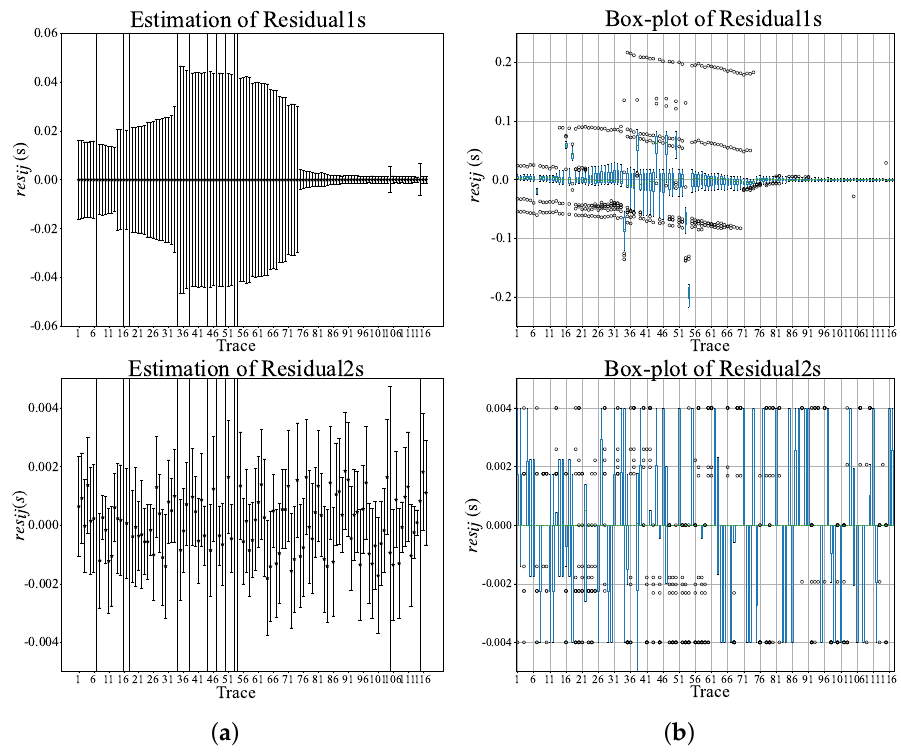
Figure 8. Assessment of results obtained by MCCC and improved MCCC: ( a ) mean and variance, and ( b ) median and interquartile range based on residual1s ( Lag 2